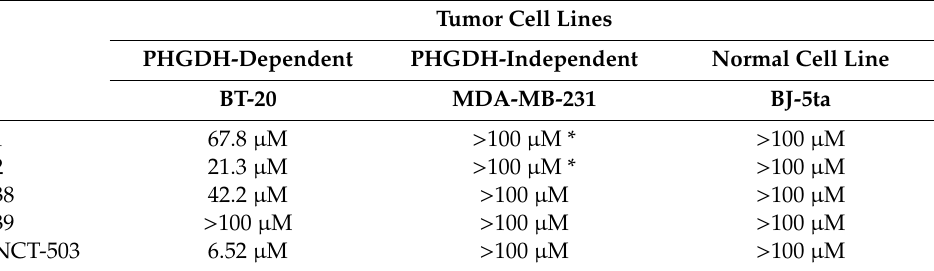
Table 5. Cell proliferation inhibition data (IC 50 ). All experiments to determine IC 50 values were performed with at least triplicates at each compound dilution, and all IC 50 values were averaged when determined in two or more independent experiments. * Values previously published in Ravez et al. [25]. Tumor Cell Lines PHGDH-Dependent PHGDH-Independent Normal Cell Line BT-20